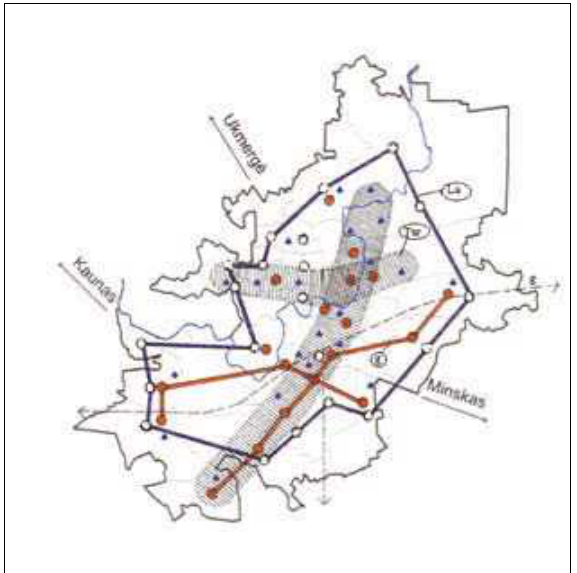
Troleibusų linijų tinklas La – lengvojo automobilio didesnio naudojimo rajonų grandinė; Troley­bus Tw , G – tramvajaus, geležinkelio vystymo didesnio aktualumo rajonai; g – esamos geležinkelio